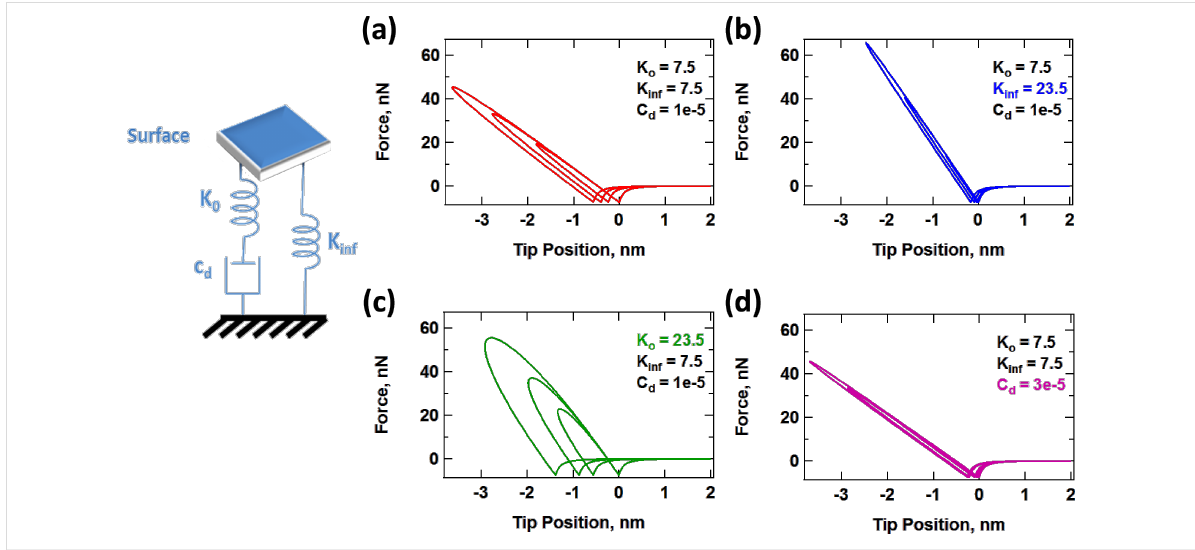
Figure 10: Example of the evolution of force–distance trajectories with changes in the SLS surface parameters: (a) baseline; (b) increase in K inf ; (c) increase in K 0 ; (d) increase in C diss . The parameters are similar to those given for Figure 7, except for A 2-free = 5 nm and any other parameters indi- cated in the